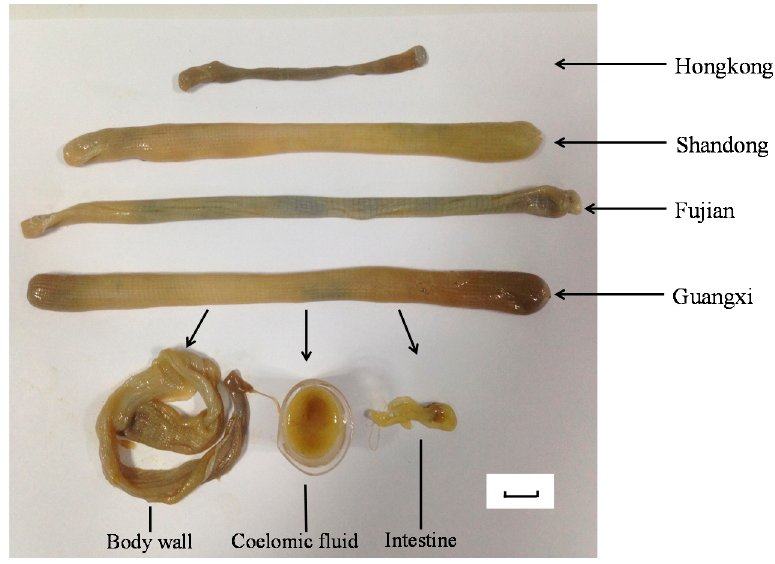
Figure 5. The appearance and anatomy of samples collected from four different habitats.